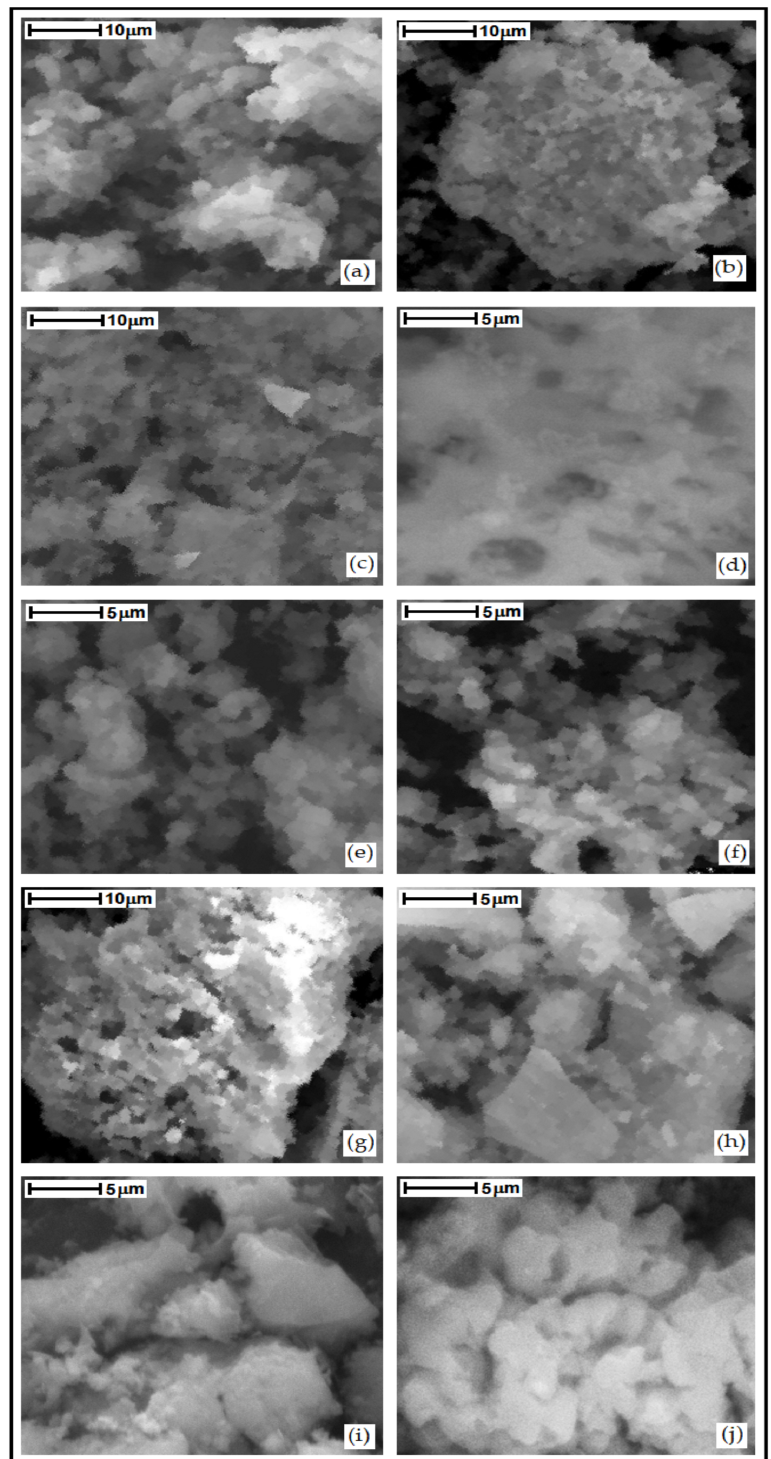
Figure 9. Scanning electron micrographies of the synthesized materials: ( a ) SiO 2 ; ( b ) La–SiO 2 ; ( c ) Ce–SiO 2 ; ( d ) Pr–SiO 2 ; ( e ) Nd–SiO 2 ; ( f ) Eu–SiO 2 ; ( g ) Gd–SiO 2 ; ( h ) Dy–SiO 2 ; ( i ) Yb–SiO 2 ; ( j) Lu–SiO 2 .